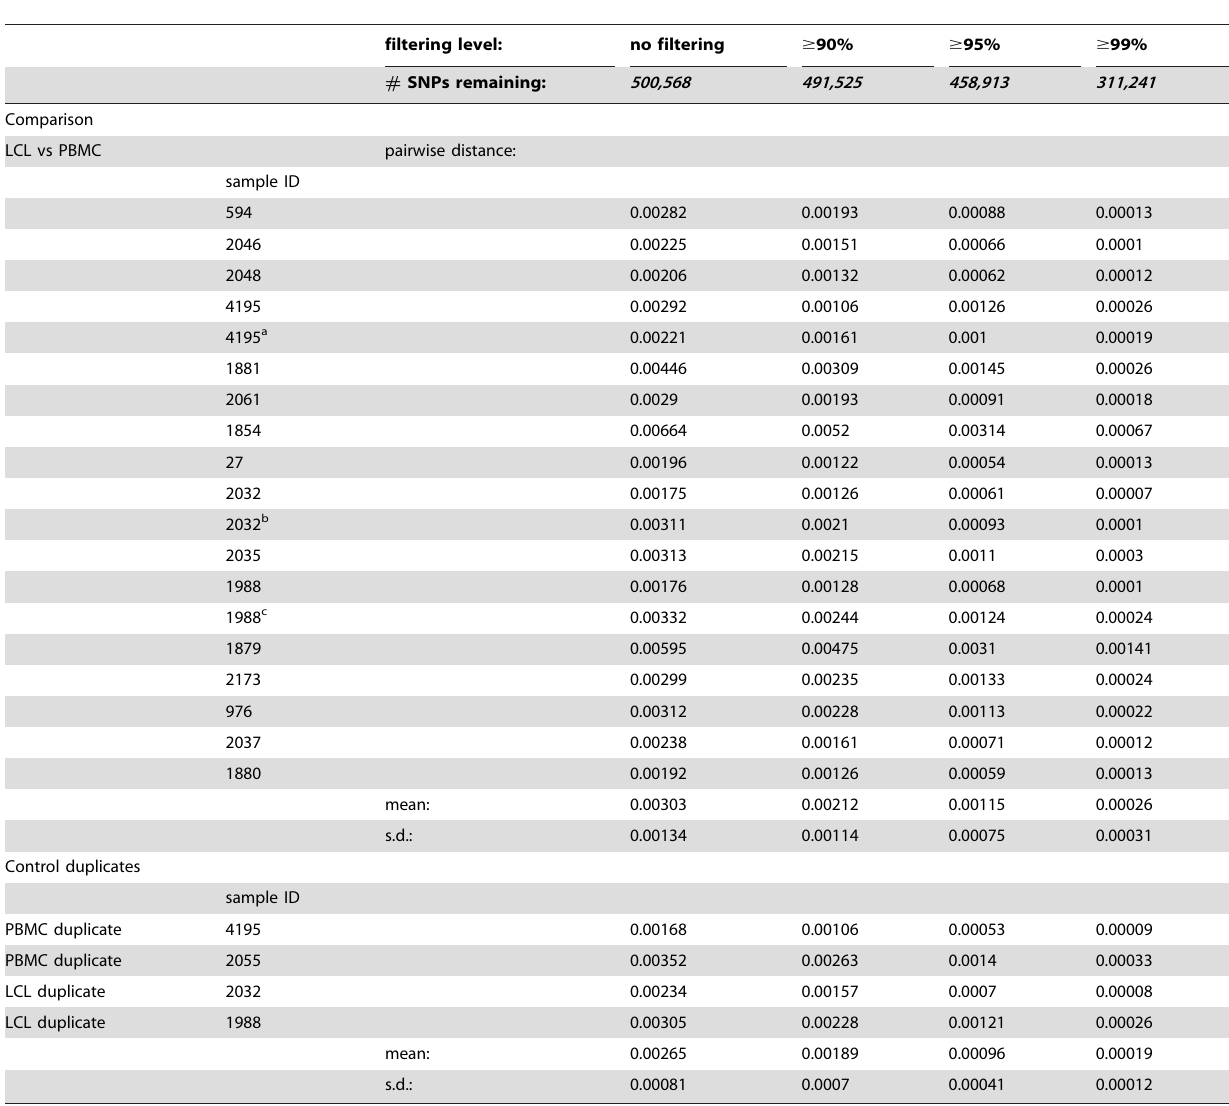
Table 1. Genotype fidelity between paired DNA samples, with SNPs filtered at increasing population call rates.